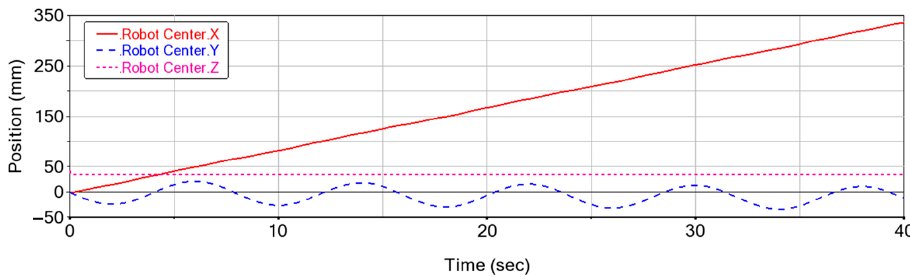
Figure 9. Variations in the center of mass for five walking cycles.